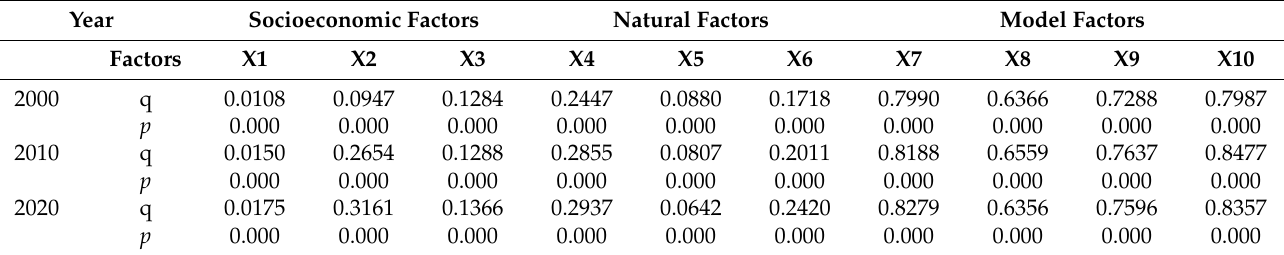
Table 5. Influence of factors on RSEI between 2000 and 2020.